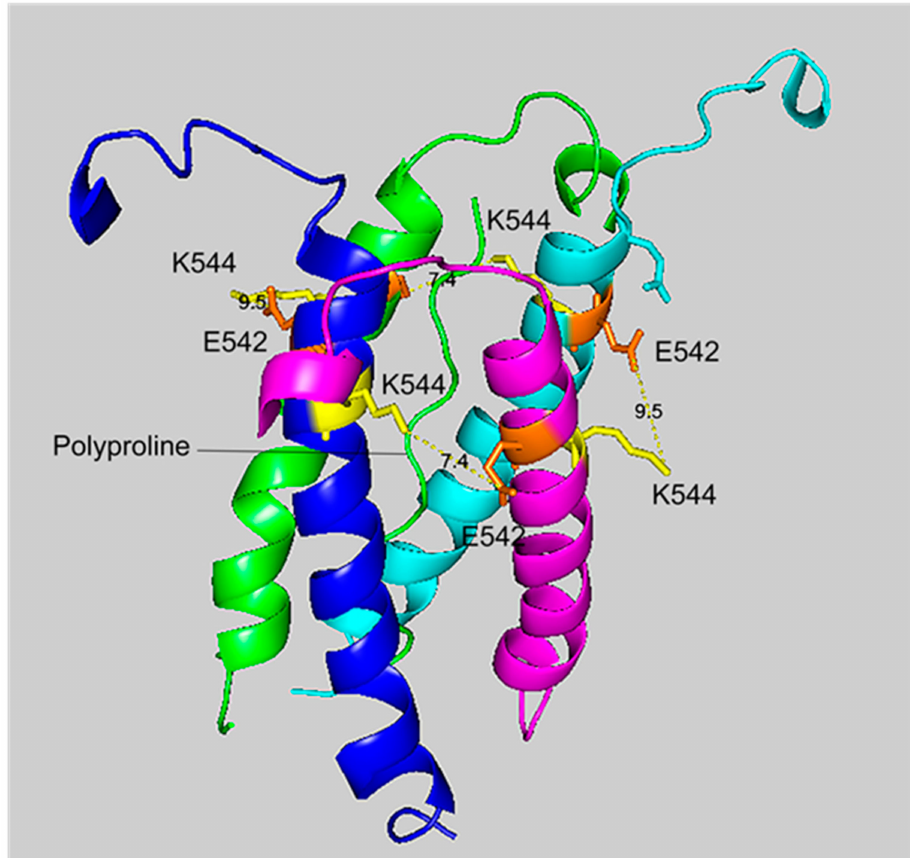
Figure 5. A side view of the crosslinking region of tetrameric HuBChE illustrating the location of the crosslinked residues for the peptide pair VLEMoxTGNIDEAEWEWK 544 AGFHR– VLEMoxTGNIDEAEWE 542 WK. The C-terminal alpha helices from the four HuBChE monomers are shown surrounding the tetramer forming polyproline II helix. Crosslinking glutamates are shown in orange. Crosslinked lysines are shown in yellow. The proposed crosslink distances of 9.5 Å and 7.4 Å are indicated with a yellow dashed line and the distance is given in Å. Deep-blue, purple, light blue and green identify α -helices from di ff erent HuBChE